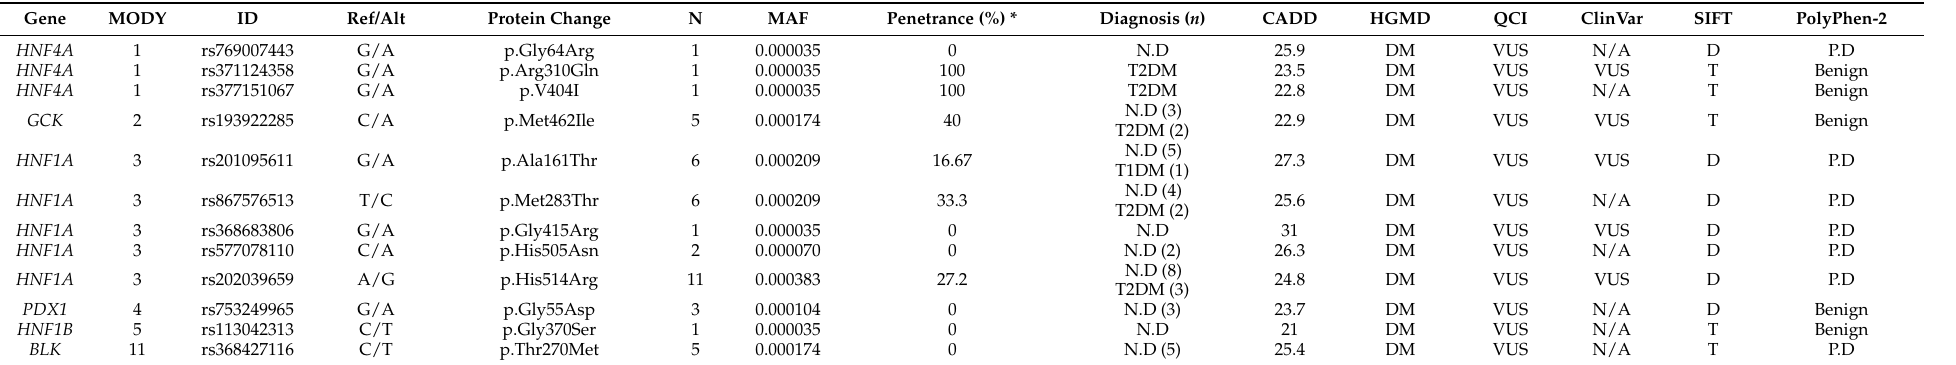
Table 3. Identification of previously reported disease-causing or likely disease-causing variants in the Human Gene Mutation Database, predicted to be among the top 1% most deleterious mutations in the human